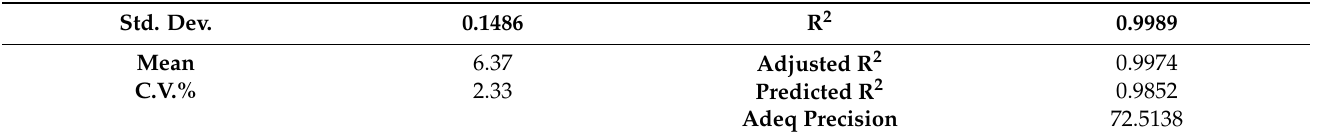
Table 7. Fit statistics of the solid drying time.